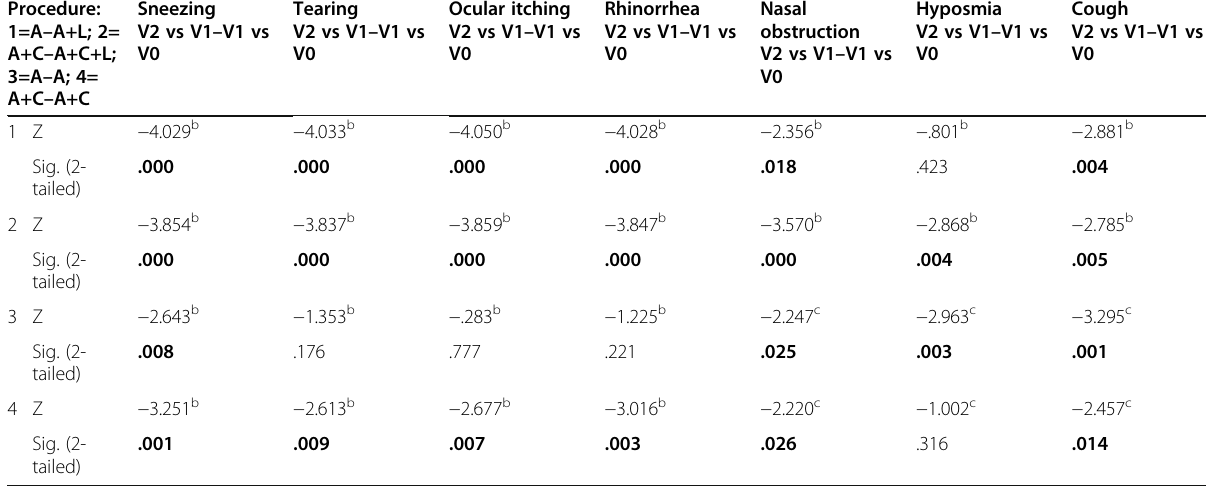
Table 4 Statistical significances of differences in the percents of improvement in nasal and ocular symptoms (V2 vs V1 – V1 vs